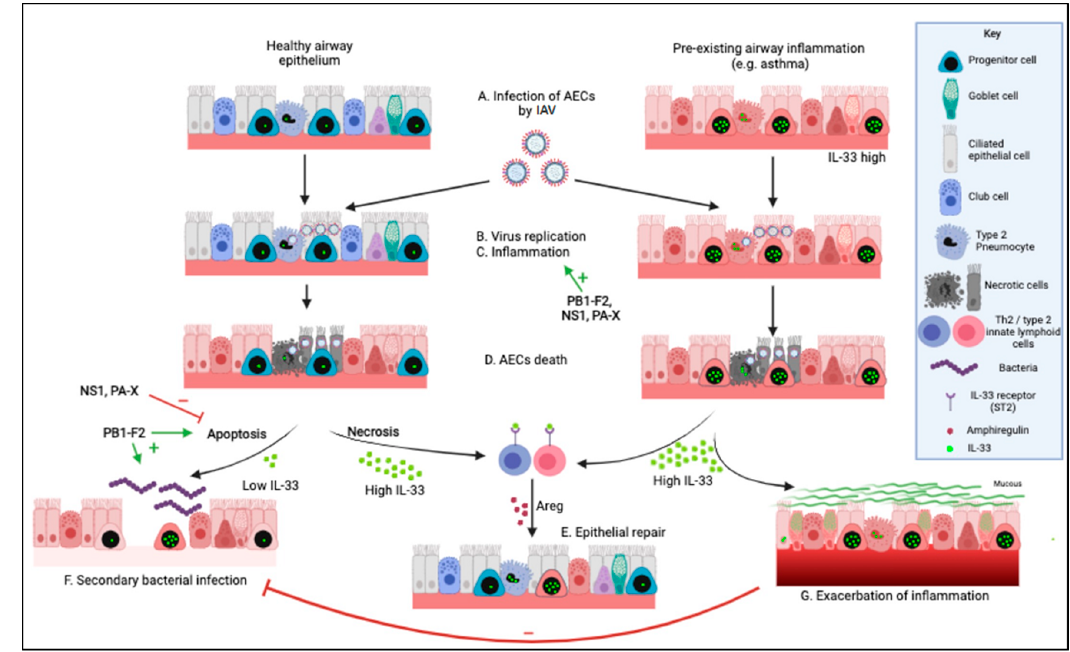
Figure 1. Effects of influenza A virus on the respiratory epithelium. In healthy individuals, ( A ) influenza A virus (IAV) infects airway epithelial cells (AECs). Viral replication ( B ) and/or inflammation ( C ) cause extensive AEC death ( D ). Evidence from other species indicates that the alarmin Interleukin-33 (IL-33) cytokine plays a key role in airway epithelial repair ( E ), by binding the IL-33 receptor on T regulatory cells (Tregs) and innate lymphoid cells type 2 (ILC2s) and inducing amphiregulin (AREG) production. In turn, AREG promotes airway progenitor proliferation and repair of the airway epithelium. Additionally, the death of AECs during an IAV infection can be of two types, apoptosis or necrosis, each directly impacting in opposing ways on the level of bioactive IL-33 released in the extracellular space. Apoptosis leads to inactivation of IL-33, thus limiting airway inflammation, but potentially increasing the risk of secondary bacterial infection ( F ). On the other hand, necrosis allows the release of high levels of bioactive IL-33, which is necessary for the prevention